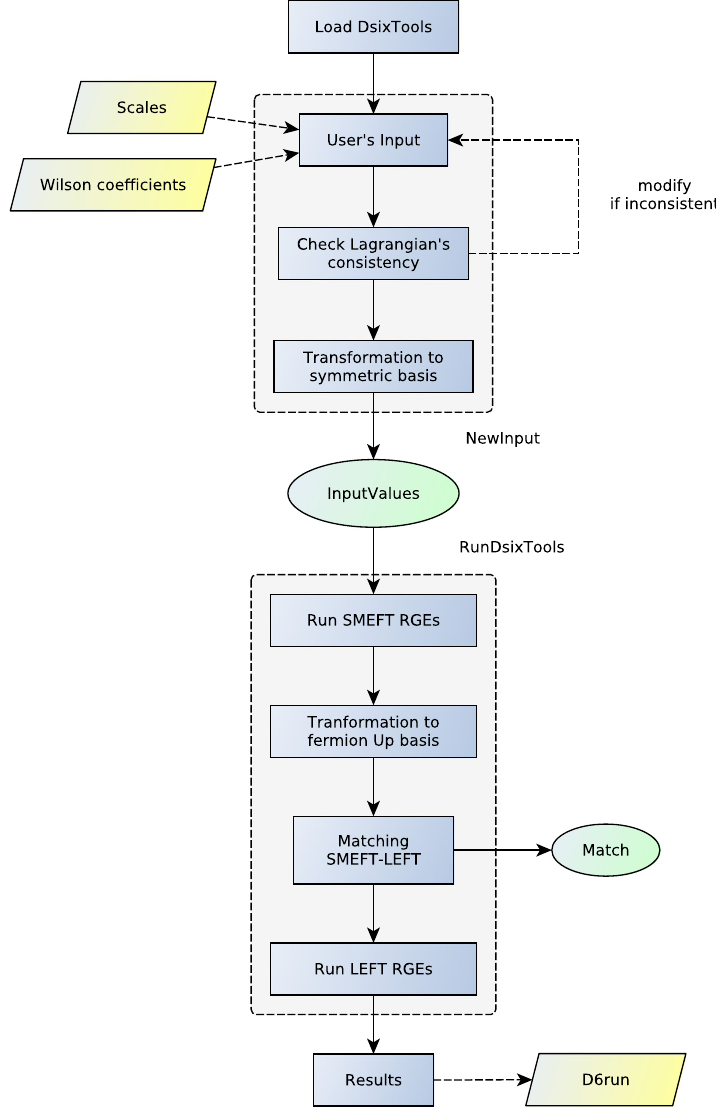
Fig. 2 Example of a minimal DsixTools program flowchart